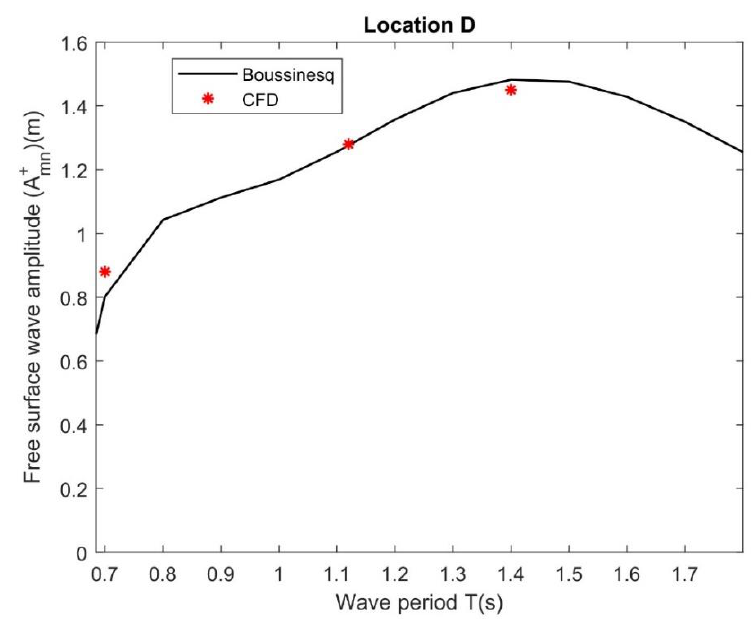
Figure 15. Comparison of Boussinesq, second-order super-harmonic wave amplitude mn A Equation (29) and CFD models of free surface elevation for location C.